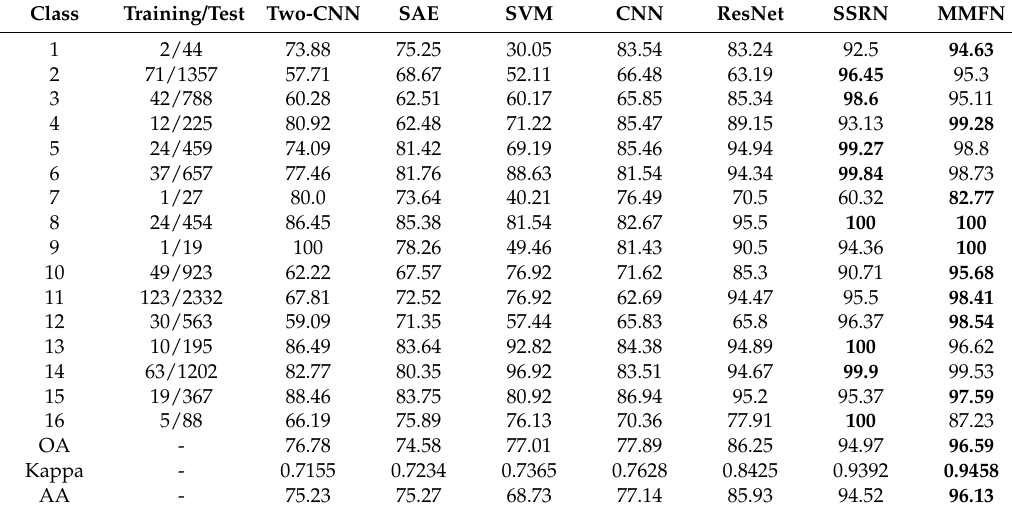
Table 9. Class-specific accuracies (%) of the Indian Pines Data